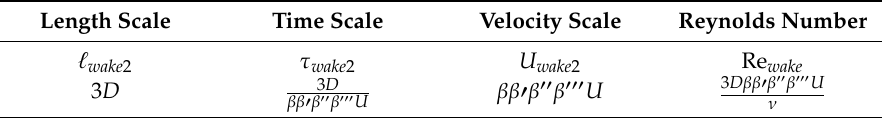
Table A4. Characteristic wake scales for two rows of VAWT